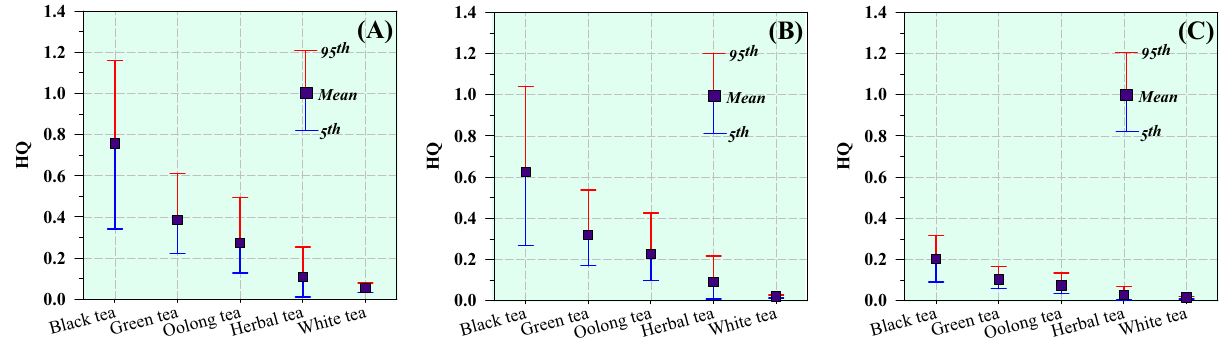
Figure 5. HQ values in ( A ) children, ( B ) teenagers, and ( C ) adults for the consumption of uncrushed tea and herbal